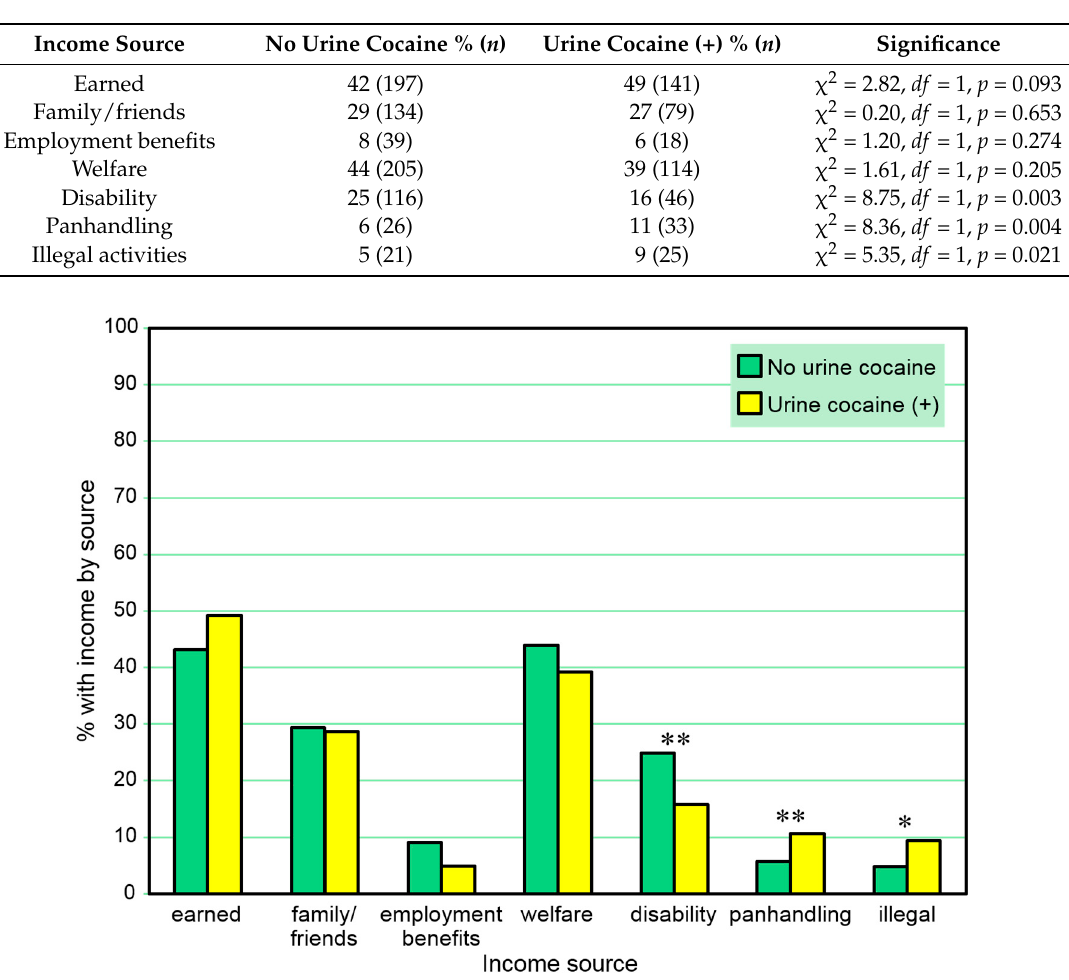
Table 2. Proportions with 30-day income sources among those with and without a positive urine cocaine test in the same month.